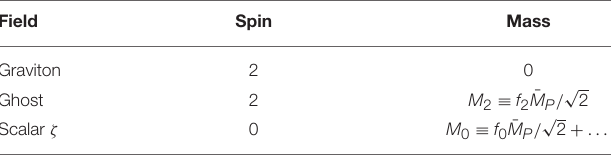
f 2 ¯ M P / √ 2 ≡ f 0 ¯ M P / √ 2 ... ≡ +